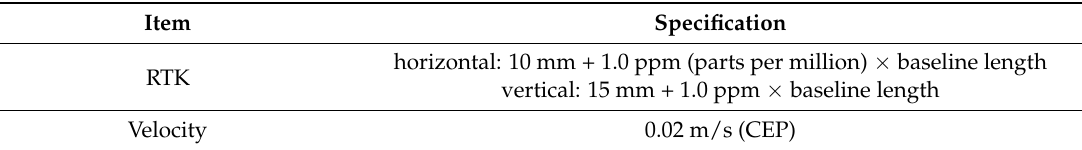
Table 2. RTK GNSS receiver accuracy